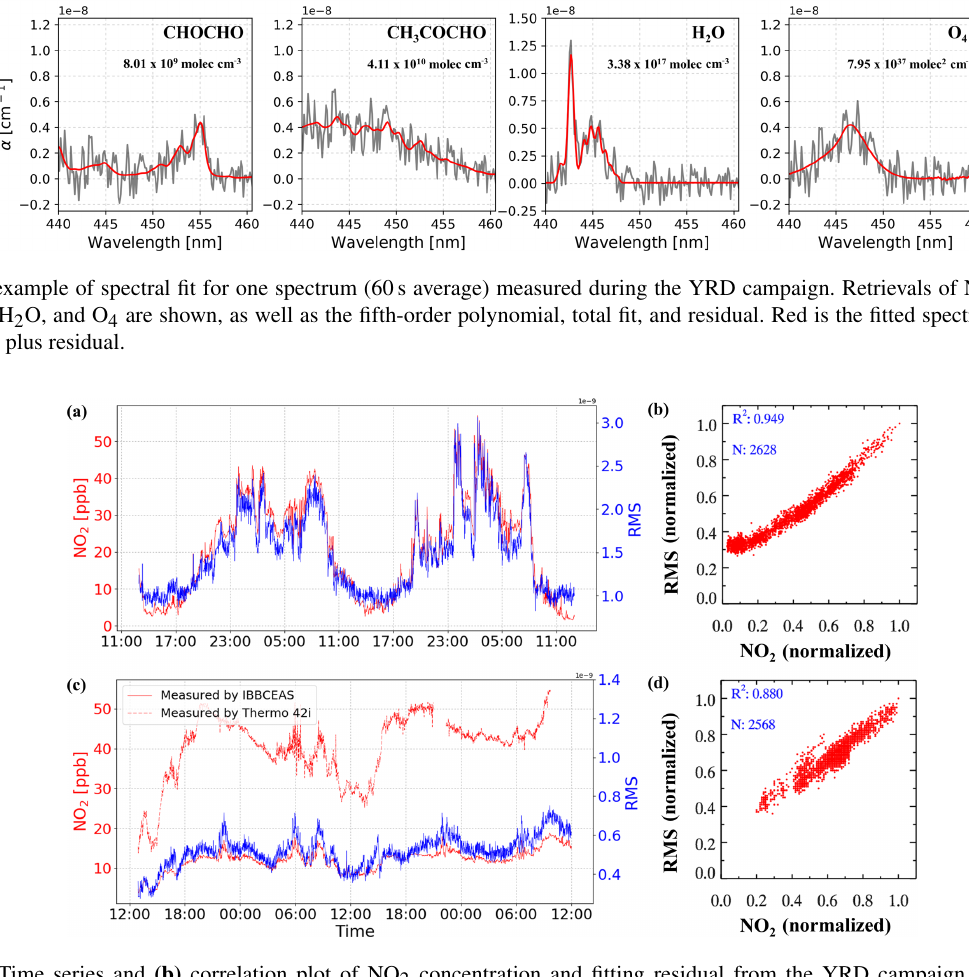
Figure 7. (a) Time series and (b) correlation plot of NO 2 concentration and fitting residual from the YRD campaign. (c) Time series and (d) correlation plot of NO 2 concentration measured by IBBCEAS and the fitting residual from the Peking University campus (PKU campaign). The NO 2 concentration and fitting residual are normalized for